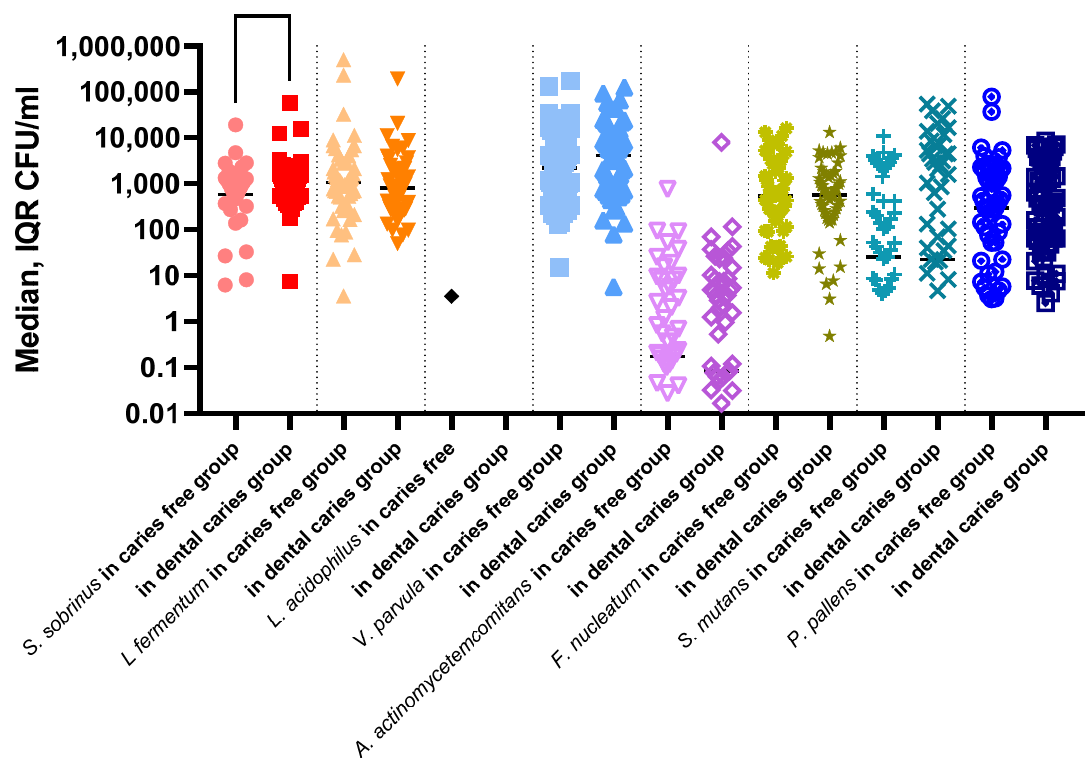
Figure 3. Abundance of bacterial species in saliva samples in the dental caries group and caries free group. (* p = 0.032, Mann–Whitney U Test: children with dental caries vs. caries free children). In the correlation analysis, S. sobrinus was positively associated with A.